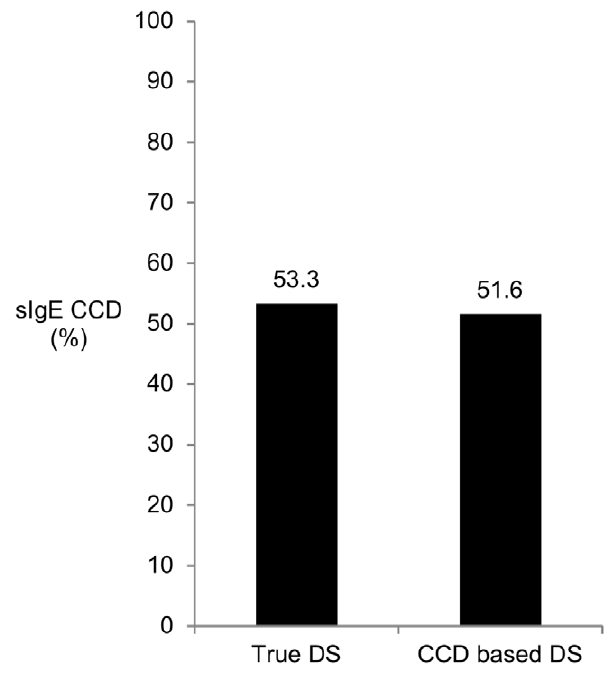
Figure 7. Determination of sIgE to MUXF (CCD) was not appropriate to distinguish between true and CCD-based double sensitization. Patients with true DS in the WB (sensitization to major allergens or hyaluronidase) had detectable sIgE to MUXF and conversely, patients with a verified CCD-based DS by the WB inhibition had no detectable sIgE to MUXF. As the coincidence of true DS and detectable sIgE to MUXF was high, results could be misinterpreted and true DS could be easily overlooked.